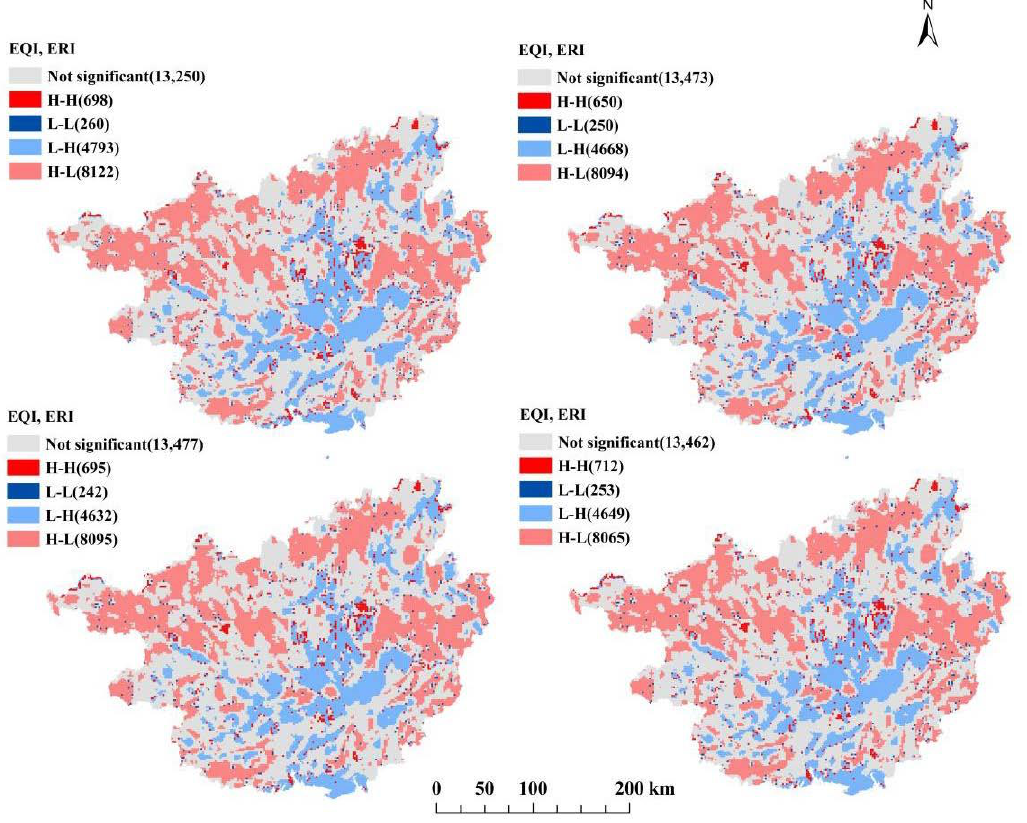
Figure 9. Bivariate LISA maps of eco-environmental quality and landscape ecological risk in Guangxi, China, during 1990–2018.